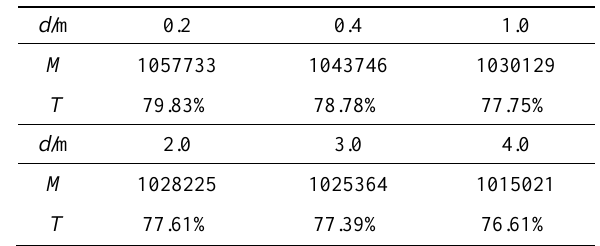
Table 2. Filter results with different width region(K=20mm)